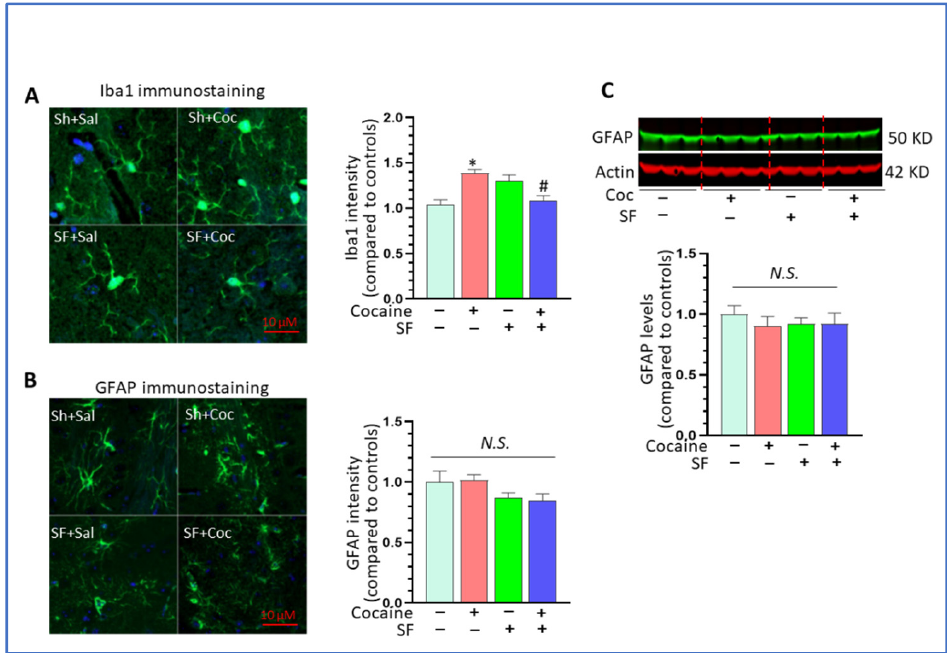
Figure 4. Combined effects of SF and cocaine on astrocytes. ( A ) Cocaine increased the signal intensity of Iba1 signaling and SF blocked its upregulation. Left: representative images for Iba1 immunostaining (scale bar 10 µ M); right: statistical analysis for Iba1 signaling in these four groups of mice (* p < 0.05, vs. sham + saline; # p < 0.05, SF + cocaine vs. sham + cocaine, n = 5). ( B ) Cocaine and SF had no effects on the intensity of GFAP signaling. Left: representative images for GFAP immunostaining (scale bar 10 µ M), right: statistical analysis for GFAP signaling in the four groups of mice ( p > 0.05, n = 5). ( C ) Representative GFAP WBs image for the striatum across groups of mice; β -actin were served as a protein load control ( p > 0.05).